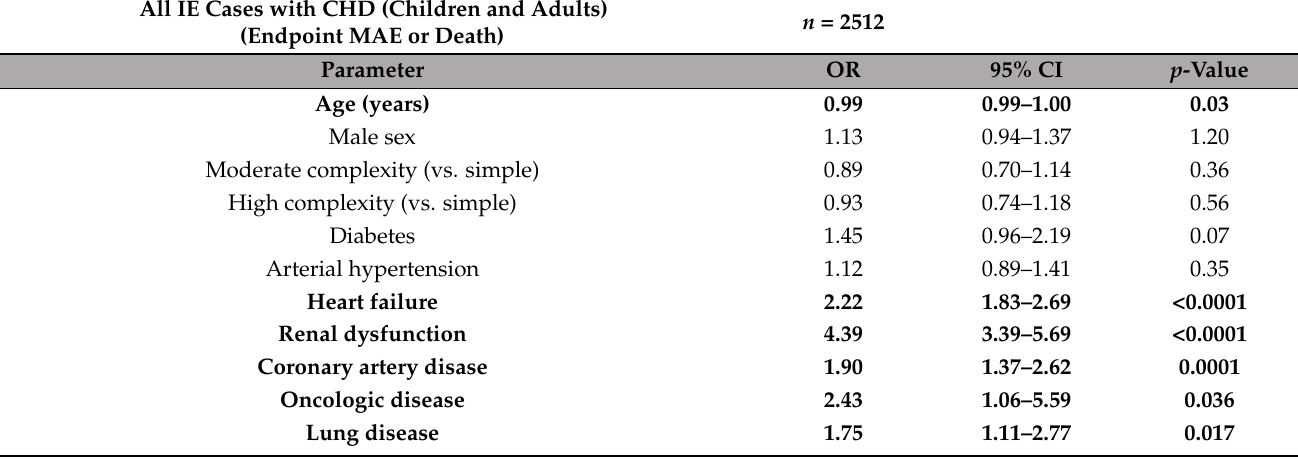
Table 7. Association between age, sex, disease complexity and co-morbidities, and major adverse events or death in congenital heart disease patients with infective endocarditis. IE = infective endocarditis; CHD = congenital heart disease; MAE = major adverse events; CI = confidence interval; OR = odds ratio. Significant variables are in bold. All IE Cases with CHD (Children and